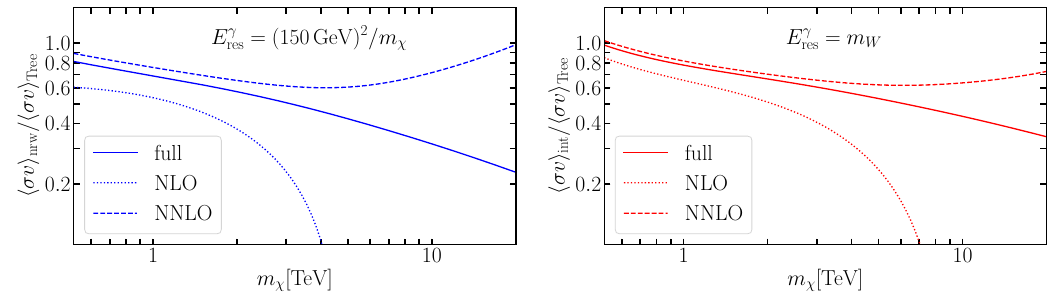
Figure 6 . Left: ratios to the tree-level cross section of the various fixed-order cross sections at NLO (dotted) and NNLO (dashed) and of the fully resummed NLL’ cross section (solid) for the = (150 GeV) 2 /m χ . Right: the same ratios as in the left panel, but in the narrow resolution E γ res = m W . As in figure 3, in both cases the Sommerfeld factor S IJ intermediate resolution regime E γ res is included and the formulas are evaluated at the central